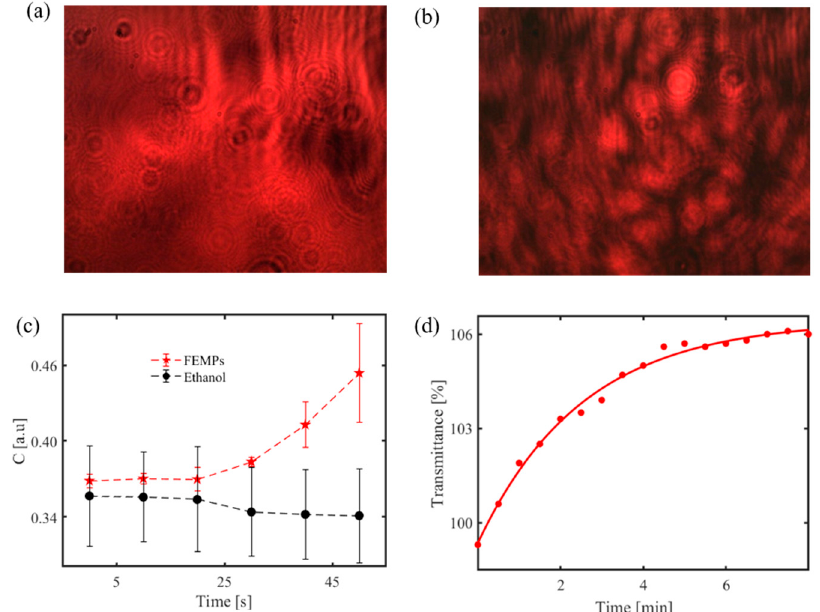
Figure 9. ( a ) Recorded interference pattern for transparent and smooth PET MP [21]; speckle pattern of similar MP with a rough surface [23]; ( b ) using the handheld optical sensor. Identification of MPs in ethanol; ( c ) time-dependent speckle contrast calculated for pure ethanol only and ethanol-containing MPs (FEMPs) on a rough glass disk using a handheld optical sensor; ( d ) time-dependent transmittance signal from ethanol containing MPs at a fixed wavelength (800 nm) using a spectrophotometer. Figure 9a Reprinted from Chemosphere, 231, Asamoah, B.O.; Kanyathare, B.; Roussey, M.; Peiponen, K.E. A Prototype of a Portable Optical Sensor for the Detection of Transparent and Translucent Microplastics in Freshwater, 161–167. [21], Copyright (2019), with permission from Elsevier; Figure 9b Reprinted from Chemosphere , 254, Asamoah, B.O.; Roussey, M.; Peiponen, K. On Optical Sensing of